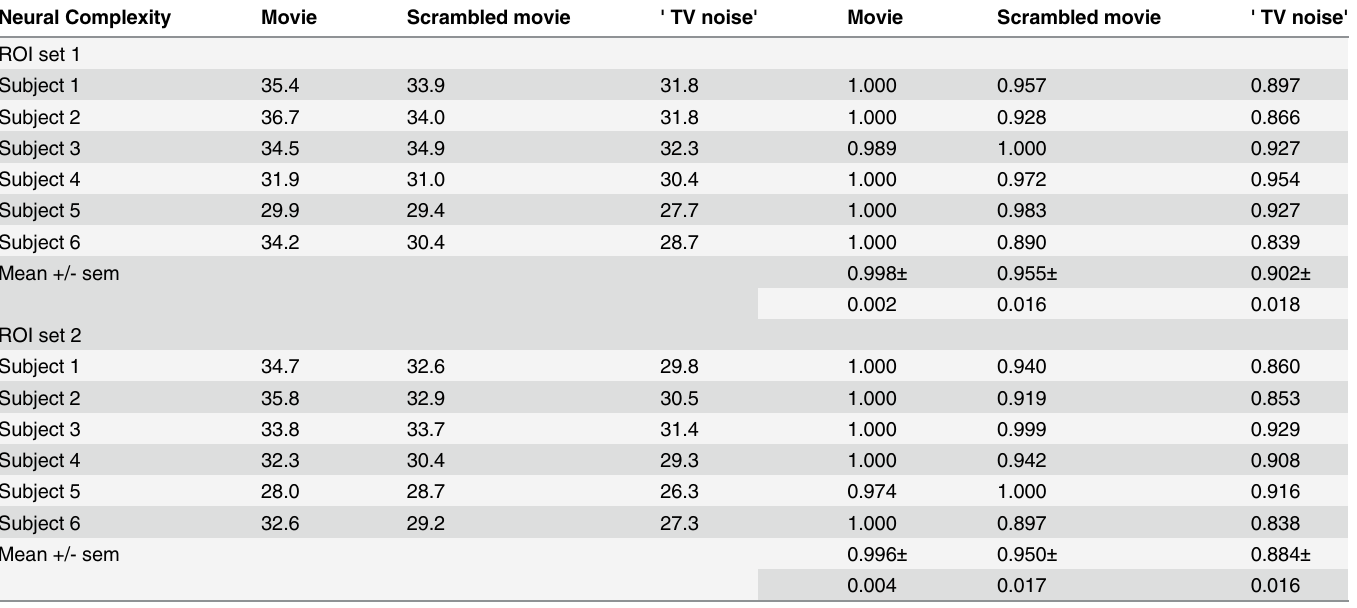
Table 5. Neural Complexity results. Neural